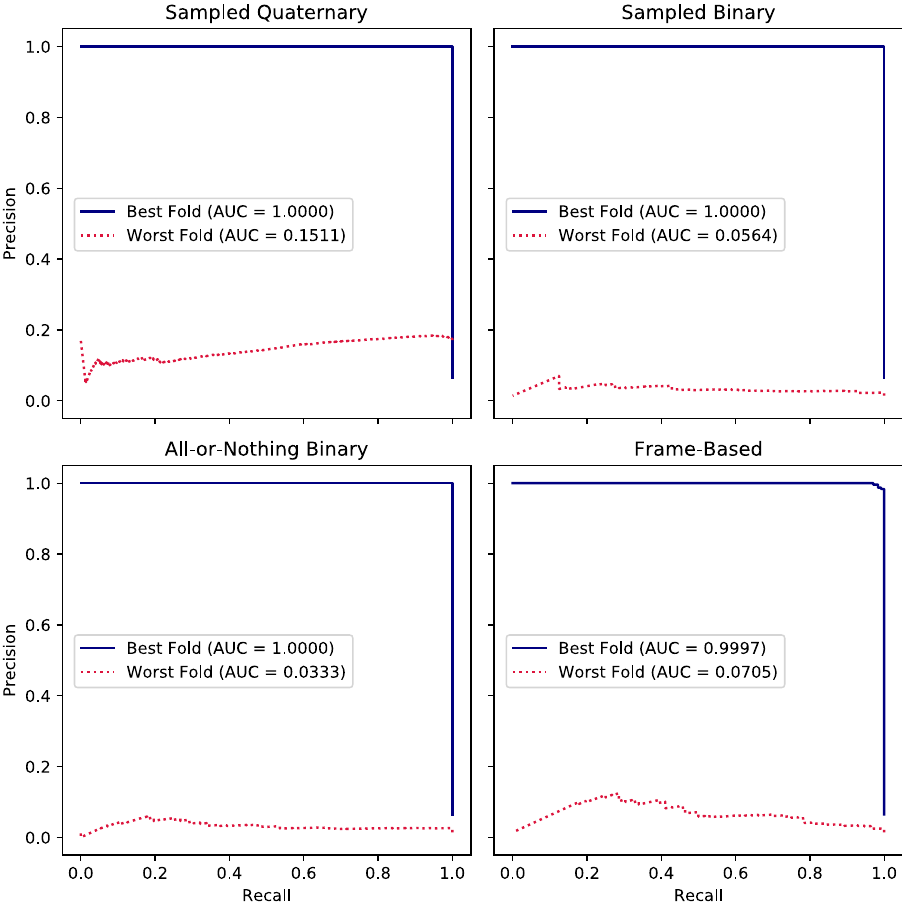
Figure 6. The best and worst fold test set precision-recall curves across the 10 folds for which videos labelled N (Section II.A2) were excluded from the training, and for which videos labelled Y* were excluded from the test set. These are given with their associated average precisions given by the Area Under Curve (AUC) scores, for models trained using the various labelling methods: the sampled quaternary and binary video-based methods, the all-or-nothing binary video-based method, and the frame-based method. One of the 10 folds, which contained only healthy frames, was excluded from the